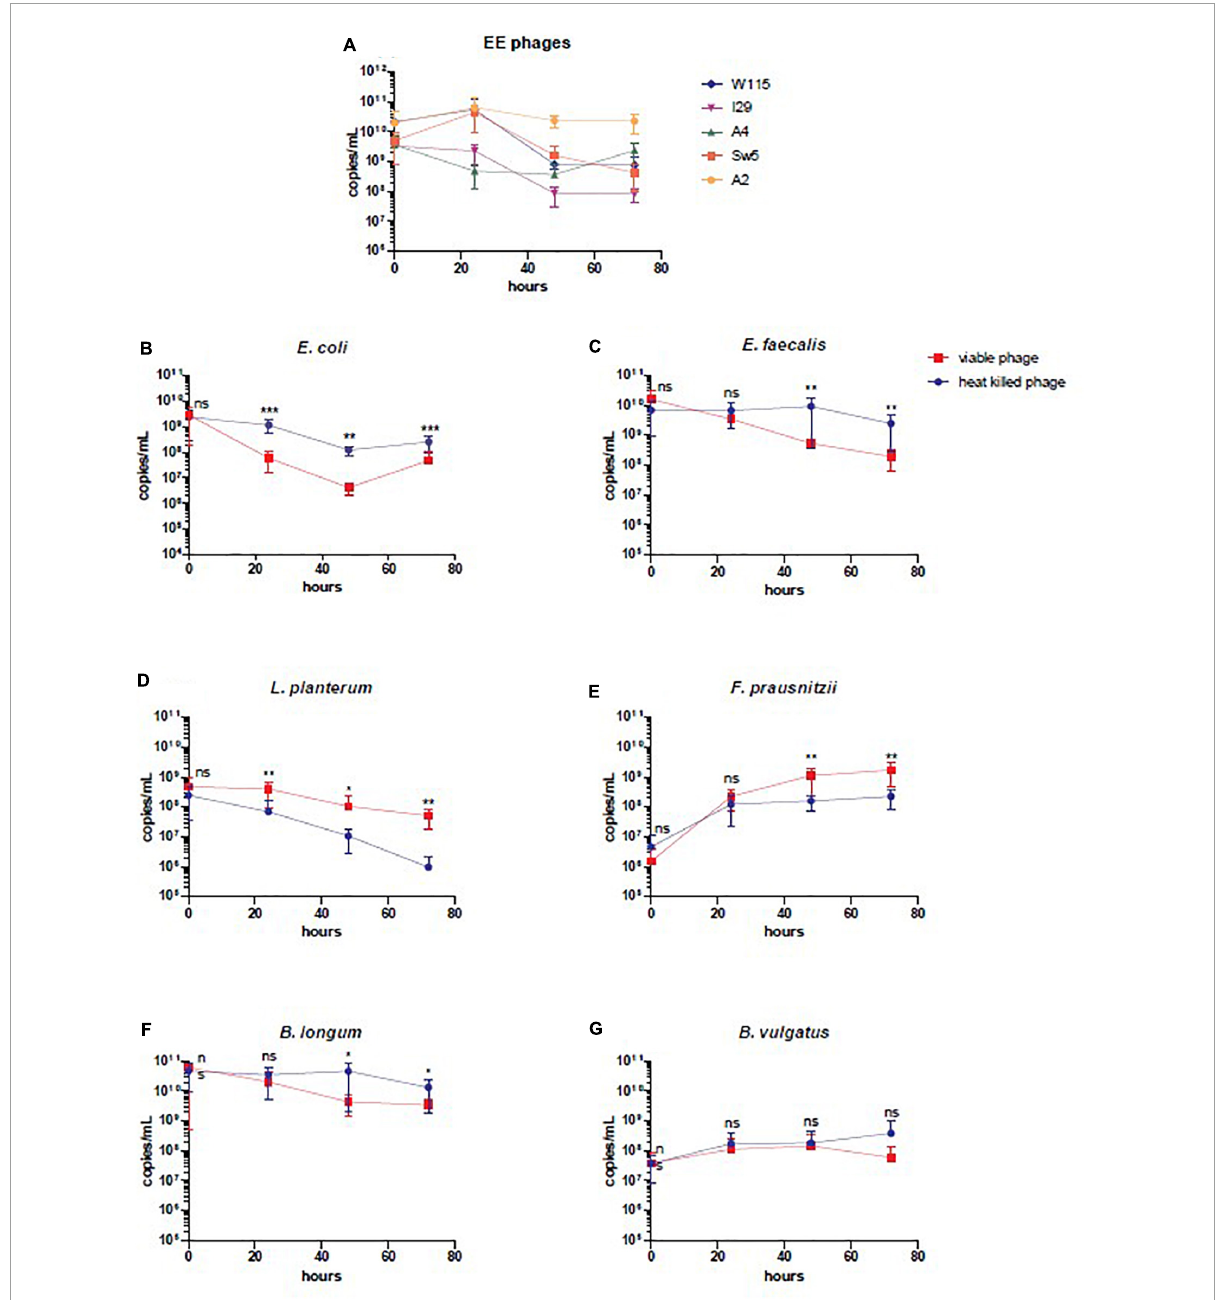
FIGURE4 Enumeration by qPCR of individual members of SIHUMI-6 consortium and EE phages. (A) EE phages, (B) E. coli LF82, (C) E. faecalis OG1RF, (D) L. plantarum , (E) F. prausnitzii , (F) B. longum, and (G) B. vulgatus , during continuous fermentation at different time points treated with heat-killed or viable phage (bars represent mean ± SD). Statistical significance was recorded as follows, not significant (ns), * p < 0.5, ** p < 0.01**, and *** p < 0.001.